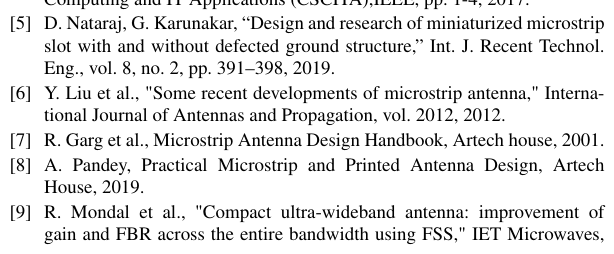
FIGURE 12. Gain of the PA, ADGS and HGWMPA.